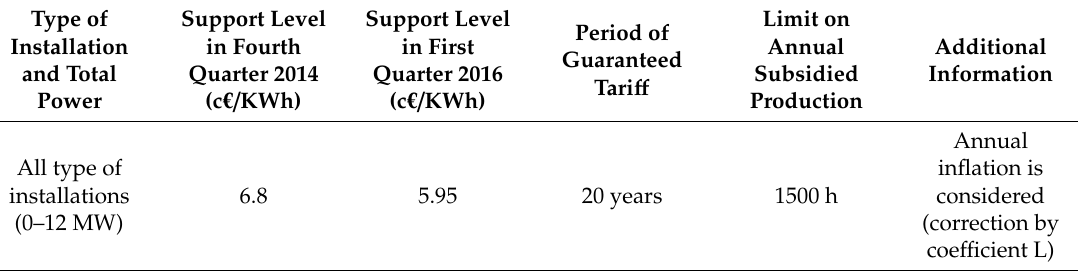
Table 1. Photovoltaic tari ff s for category